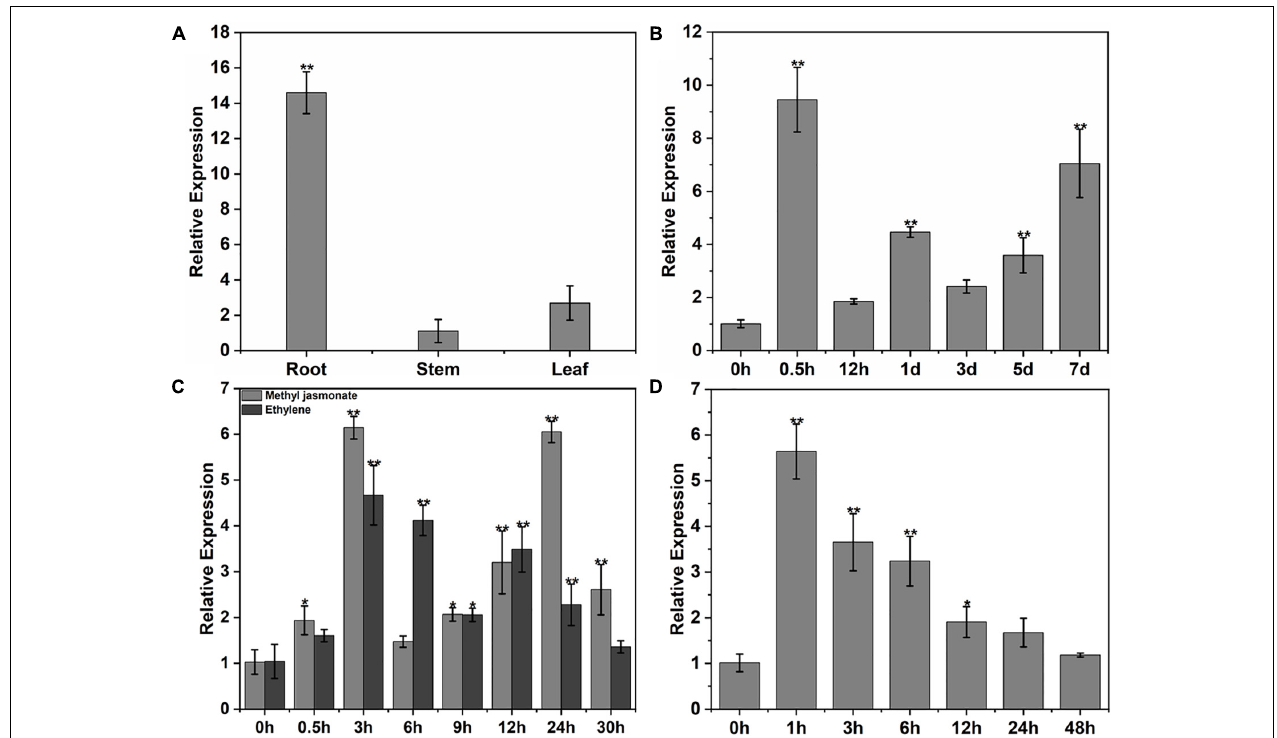
FIGURE 4 | Patterns of expression of GhPLP2 in cotton subjected to different types of stress. (A) The patterns of expression of GhPLP2 in different tissues. (B) Expression of GhPLP2 after inoculation with Verticillium dahliae . (C) Expression of GhPLP2 after treatment with 100 µ M methyl jasmonate and 2 mM ethylene. (D) Expression of GhPLP2 after treatment with 2.5% PEG 6000 (w/v). Data were obtained from three independent biological replicates and presented as the mean ± standard error. Asterisks indicate a significant difference compared with the control. ( *P < 0.05, **P < 0.01, Student’s t -test).